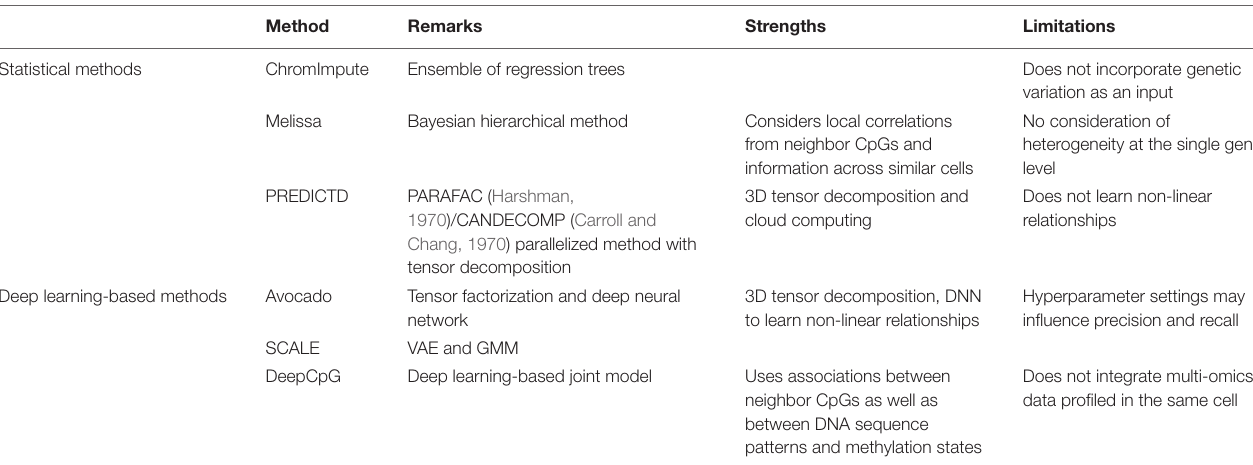
TABLE 3 | Epigenomic data imputation